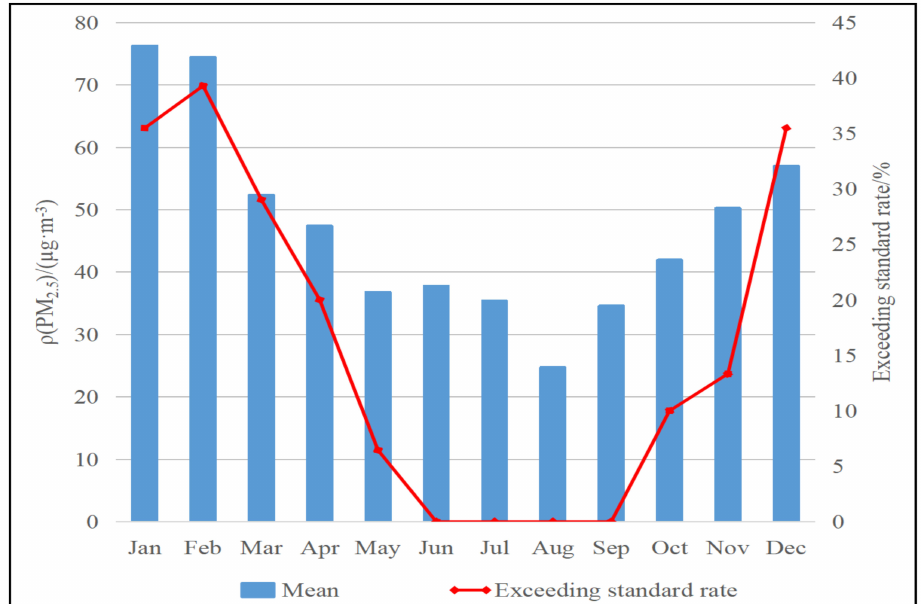
Figure 3. Mean, maximum, and minimum monthly PM 2.5 concentrations, as well as the percent of days exceeding standards, for the Beijing-Tianjin-Hebei region in